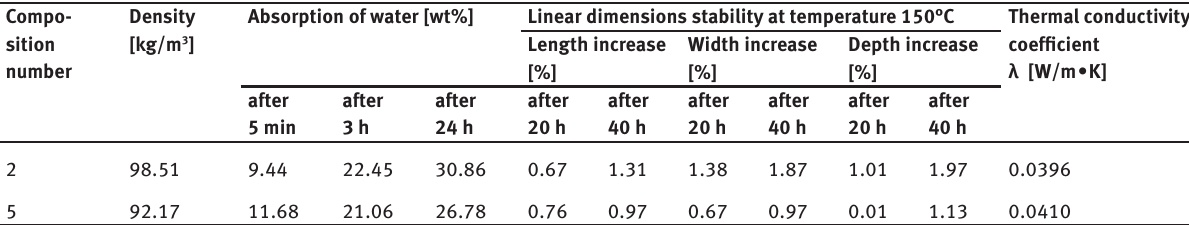
Table 3: Some properties of selected polyurethane foams. Compo- sition number